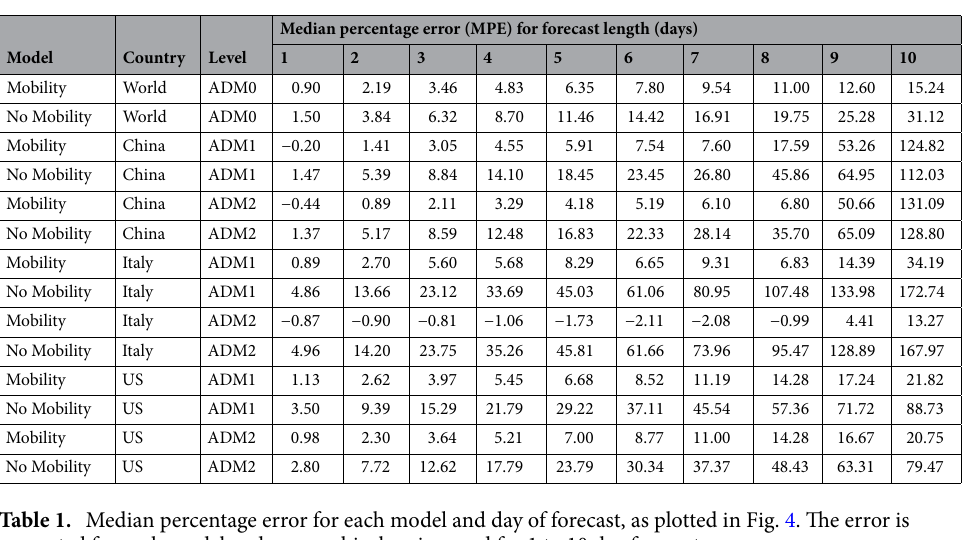
Table 1. Median percentage error for each model and day of forecast, as plotted in Fig. 4. The error is presented for each model and geographical region, and for 1 to 10 day forecasts.